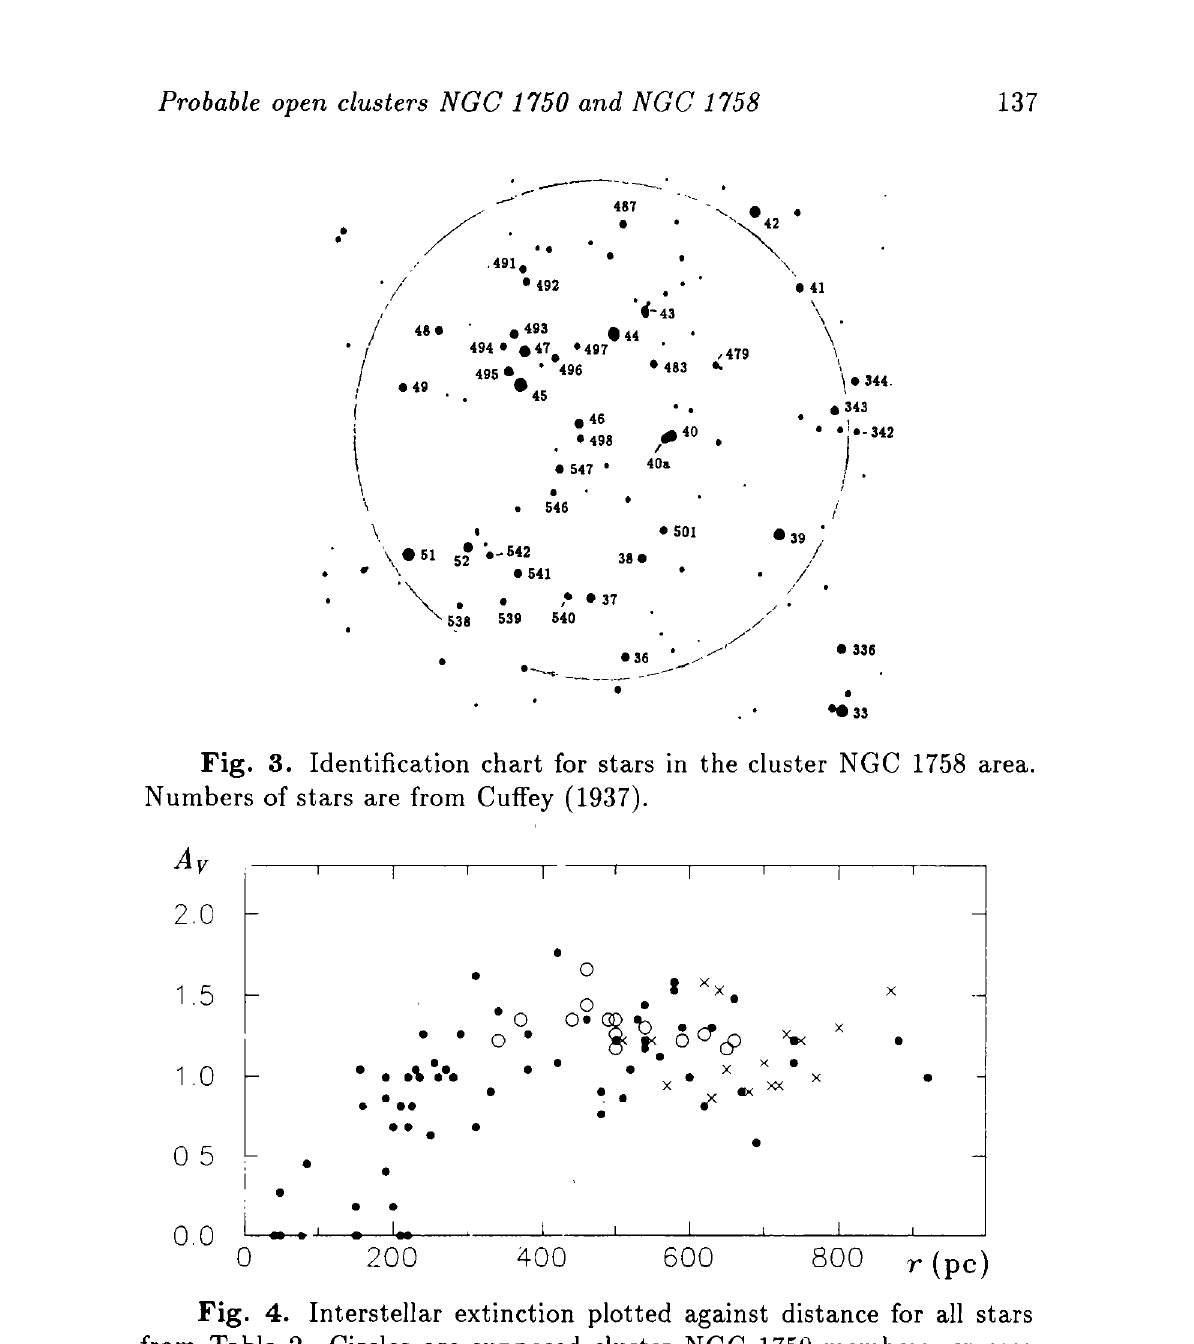
Fig. 4. Interstellar extinction plotted against distance for all stars from Table 2. Circles are supposed cluster NGC 1750 members, crosses are supposed cluster NG^ 1758 members and dots are field